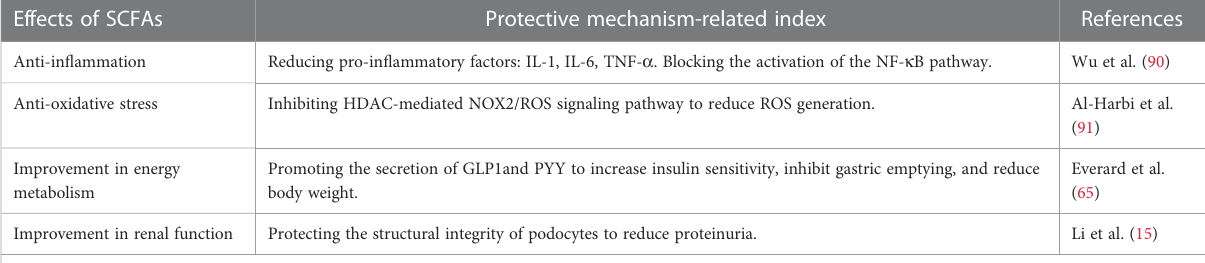
TABLE 1 Short-chain fatty acids exert multiple functions against diabetic kidney disease. Effects of SCFAs